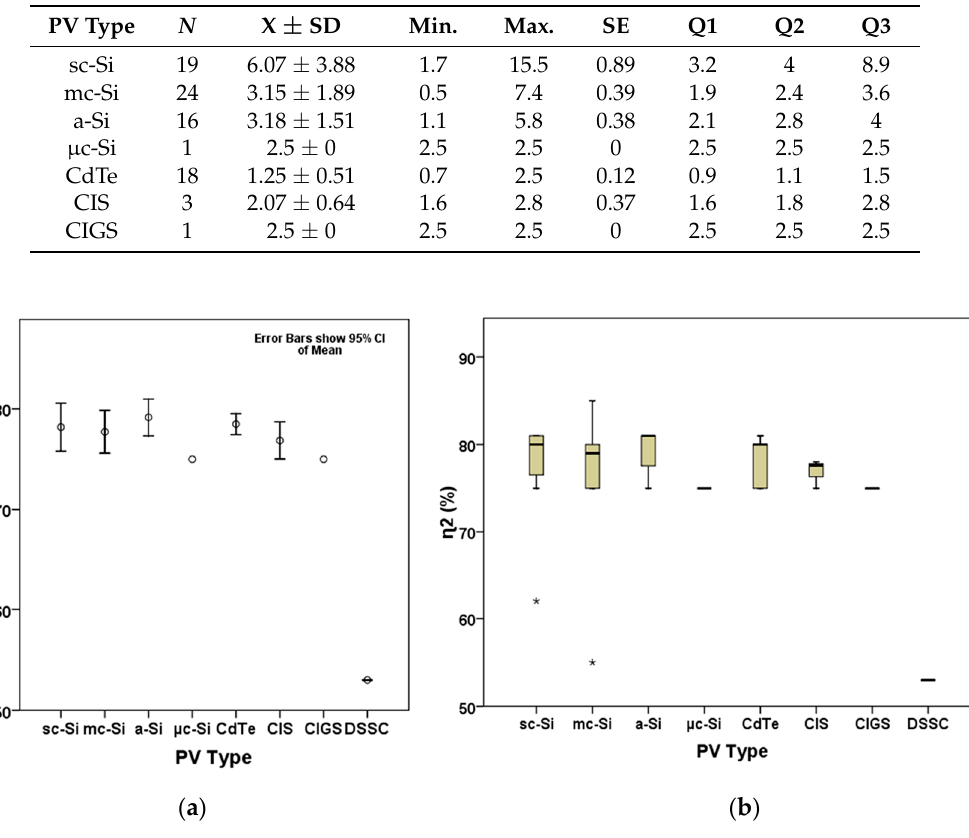
Figure 3. η 2 for different PV systems: ( a ) mean ± 95% CI error bars; ( b ) quartile box plots. Table 5. η 2 (%) statistics for PV electricity generation systems.